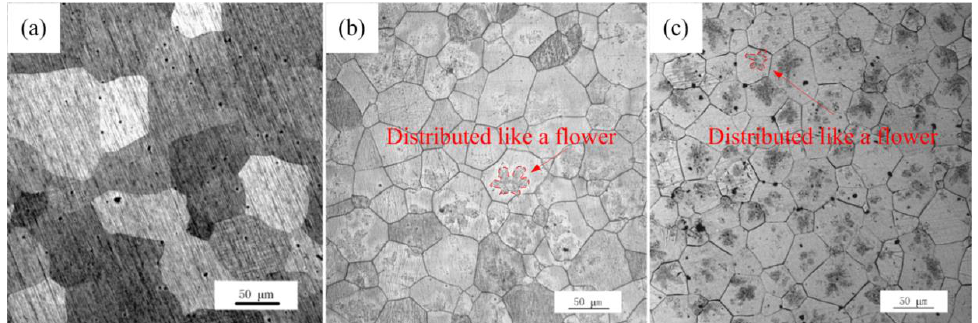
Figure 4. Microstructure of the solution-treated (ST) Mg-xGd alloys: ( a ) Mg-1Gd (ST), ( b ) Mg- and ( c ) Mg-5Gd (ST). 3Gd (ST), and( c ) Mg-5Gd (ST).